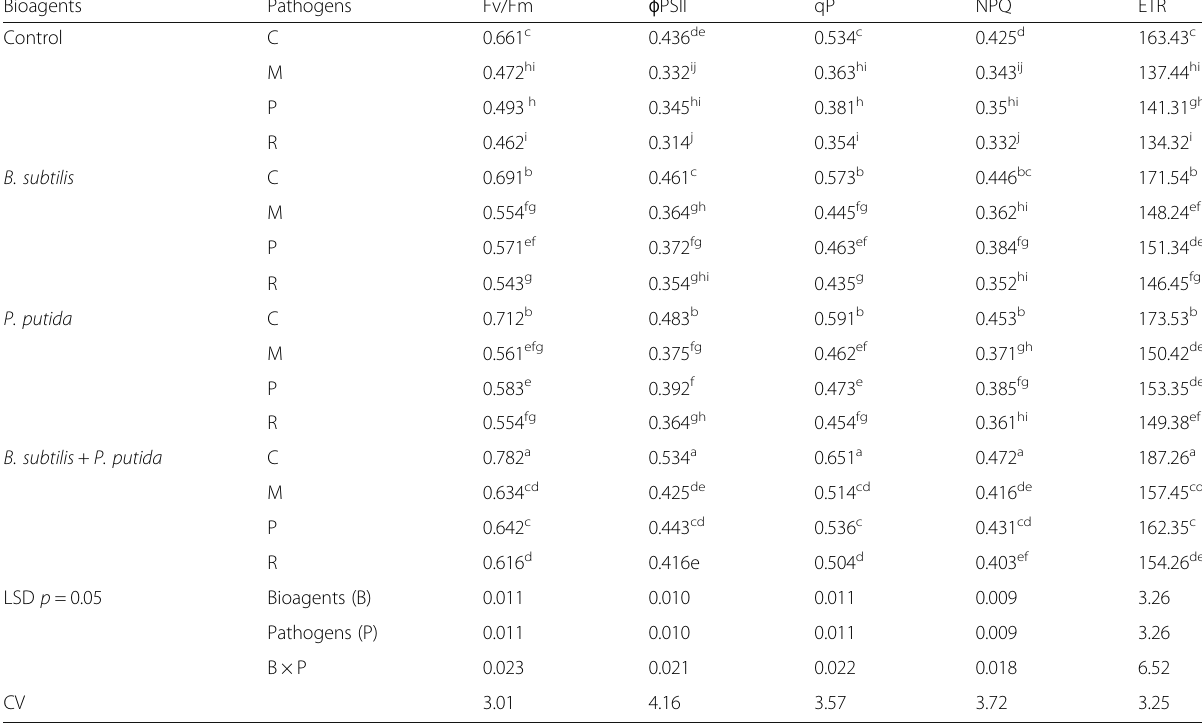
Table 3 Influence of Pseudomonas putida , Bacillus subtilis , and their mixtures on the chlorophyll fluorescence parameters of beetroot infected with Meloidogyne incognita , Pectobacterium betavasculorum , and Rhizoctonia solani